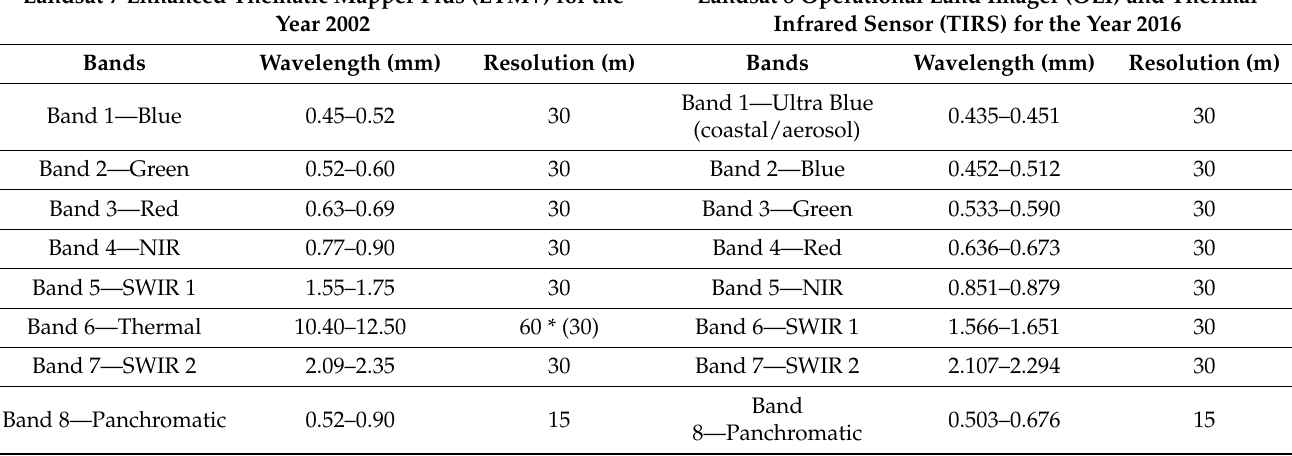
Table 1. Criteria of the satellite images used for years 2002 and